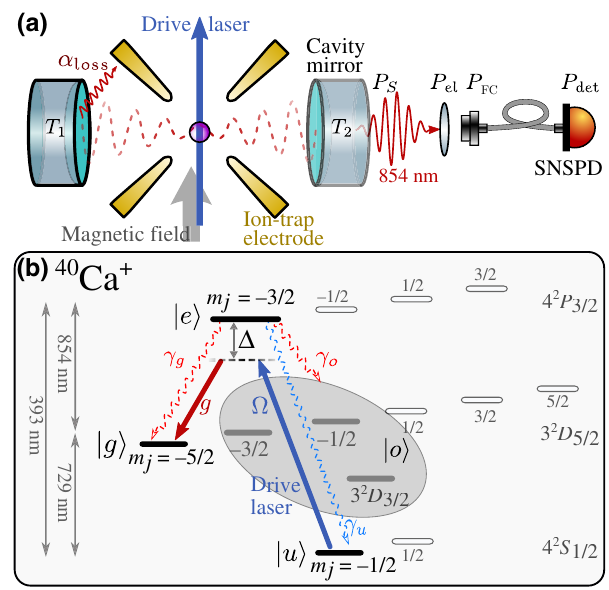
FIG. 2. Experimental setup: photon generation from a trapped ion in a cavity. (a) A 40 Ca + ion in a linear Paul trap (shown elec- trodes are for radial, in plane, confinement) and at the focus, and a vacuum antinode, of an optical cavity. The vacuum Rabi frequency of the ion-cavity coupling is g . A drive laser pulse with Rabi frequency (cid:8) causes emission of an 854-nm photon into a vacuum mode of the cavity. T 1 and T 2 are mirror trans- missions, α loss is the cavity round-trip loss, P S is the probability for obtaining a photon in the cavity output mode, P el is the trans- mission of optical elements, P FC is the fiber coupling efficiency, P det is the detector efficiency. (b) Atomic level scheme showing the CMRT for photon generation. The cavity (red solid arrow) and drive laser (blue solid arrow) have a common detuning of (cid:9)/ 2 π = − 403 ( 5 ) MHz from the excited state. Ground states other than | g (cid:2) and | u (cid:2) to which the excited state | e (cid:2) can decay are grouped in state | o (cid:2) (contained within the gray oval). The sponta- neous decay rates are (γ g , γ u , γ o )/ 2 π = ( 0.45, 10.74, 0.30 ) MHz, with γ g + γ u + γ o = γ = 2 π 11.49